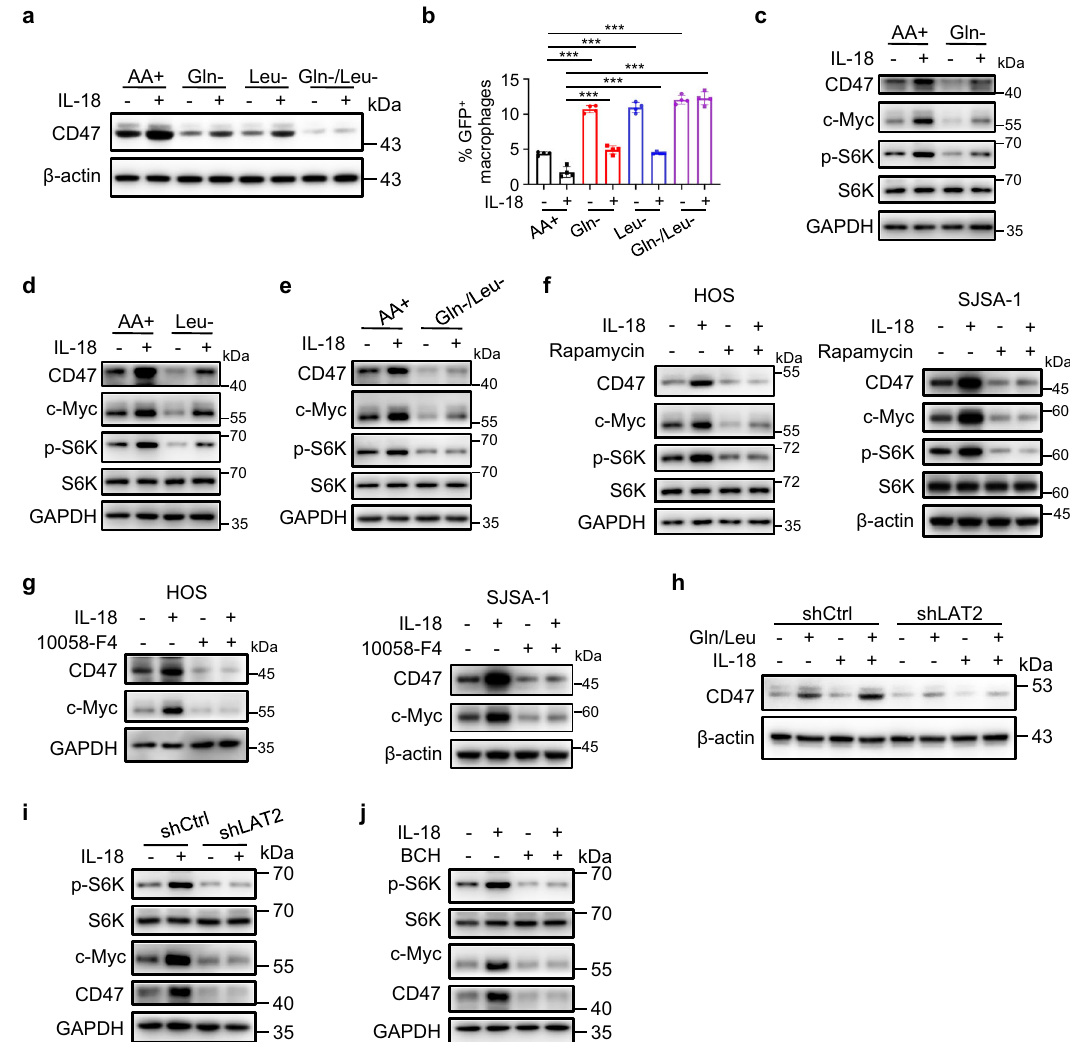
Fig. 8 | IL-18-enhanced and LAT2-mediated uptake of glutamine and leucine promoteCD47expressionbyactivatingthemTORC1/c-Mycaxis.a Westernblot analysis of HOS cells treated with PBS or IL-18 (40ng/ml) in amino acid-suf fi cient medium (AA+) or medium lacking indicated amino acids for 24h. Gln-, medium lacking glutamine; Leu-, medium lacking leucine; Gln-/Leu-, medium lacking glu- tamine and leucine. b Flow cytometry-based in vitro macrophage phagocytosis assay. HOS cells were treated with PBS or IL-18 (40ng/ml) in amino acid-suf fi cient medium (AA+), medium de fi cient in leucine (Leu-), medium de fi cient in glutamine (Gln-), medium de fi cient in glutamine and leucine (Gln-/Leu-) for 24h ( n =4 inde- pendent experiments). Macrophages were de fi ned as F4/80 + (labeled with PE) events, and tumor cells as GFP + events. F4/80 + , GFP + events represented macro- phages that had phagocytosed tumor cells. c – e Western blot analysis of HOS cells treated with PBS or IL-18 (40ng/ml) in amino acid-suf fi cient medium (AA+) or